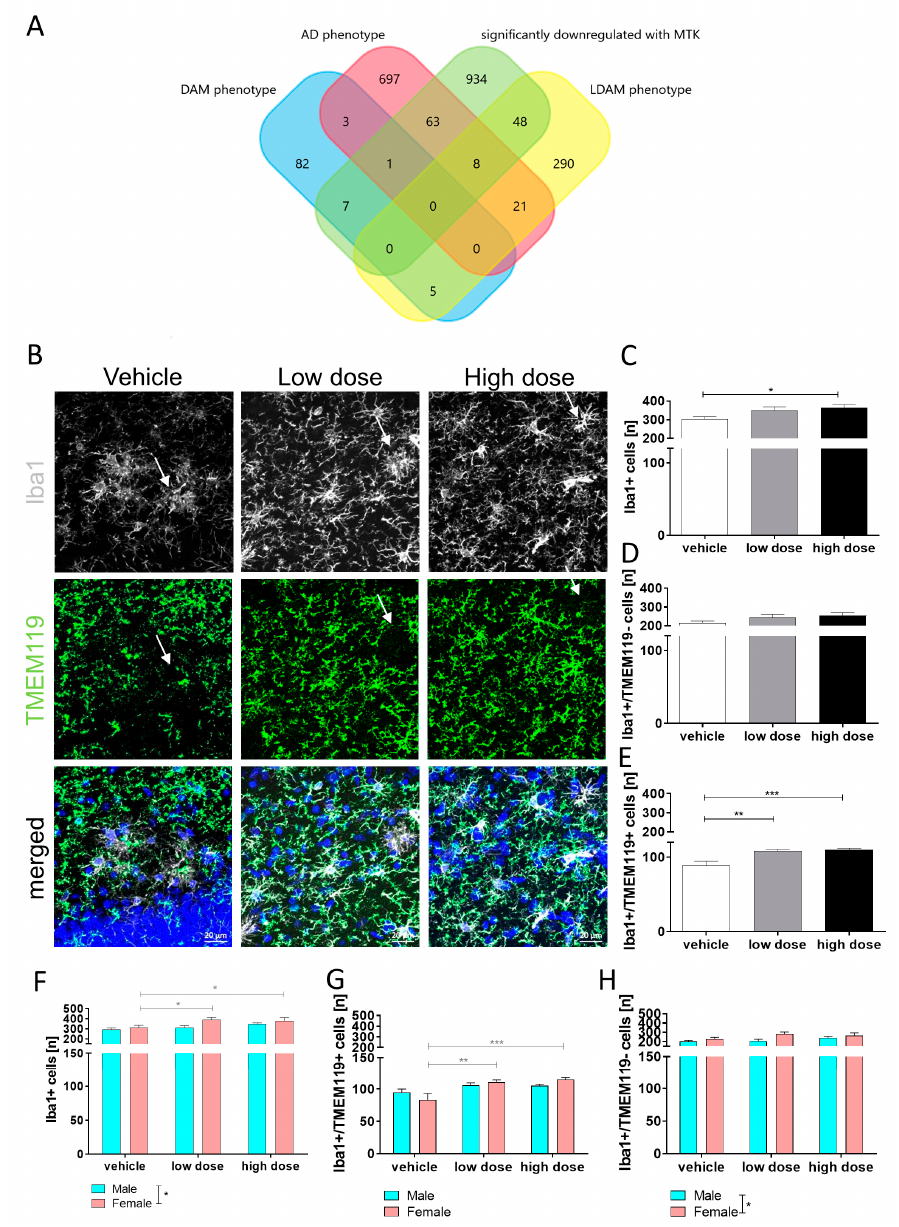
Figure 3. Bioinformatic and immunohistochemical analysis of microglia with and without MTK treatment in the hippocampus. ( A ) Overlap between genes downregulated with MTK treatment (green) and genes upregulated in lipid droplet-accumulating microglia (red), disease-associated microglia (blue) and AD microglia (yellow). ( B ) Representative images of microglia positive for Iba1 and Tmem119; scale bar: 20 µm. ( C ) We observed an increase in numbers of Iba1+ microglia with MTK, which was significant between vehicle and high dose. ( D ) No significant difference in numbers of Iba1+/Tmem119 − cells between groups. ( E ) We observed a significant increase in numbers of Iba1+/Tmem119+ microglia with MTK. ( F ) The increase in Iba1+ cells comes from female mice, which have significantly more microglia than male mice of the same age. ( G ) Numbers of cells separated by sex. Female mice have significantly more Iba1+/Tmem119 − cells than male mice. ( H ) The increase in the subpopulation comes from females, which have less of these cells in the vehicle group but increase to more of these cells in both MTK treatment groups. Data are shown as mean +/ − SEM. One-way ANOVA was performed with Tukey’s post hoc test. P -values of p < 0.0001 and p < 0.001 were considered extremely significant (**** or ***), p < 0.01 very significant (**) and p < 0.05 significant (*).